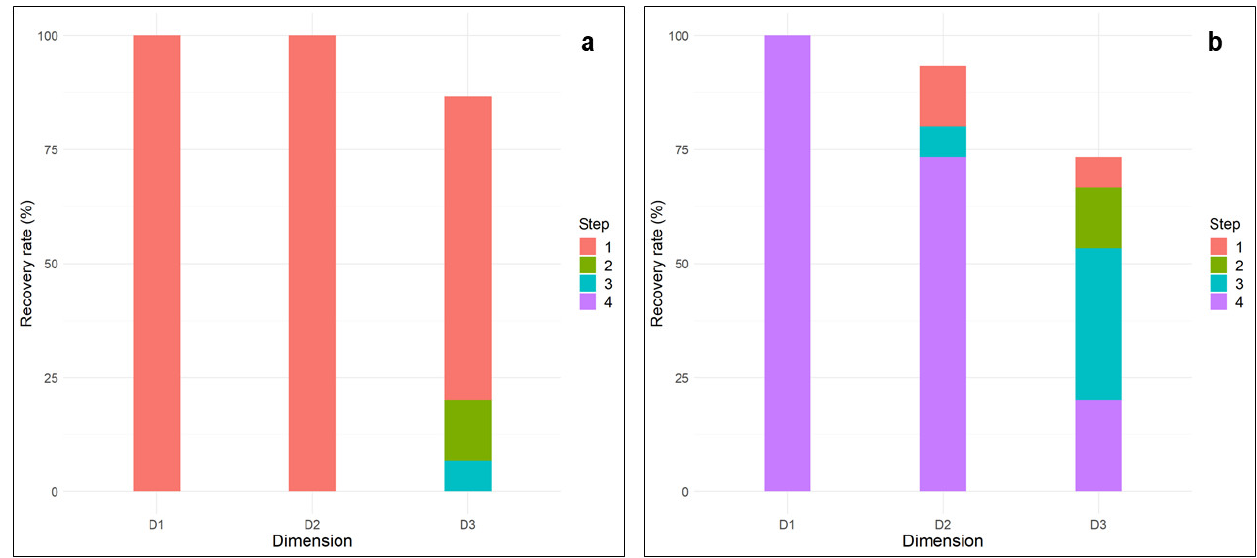
Figure 2. Average percentage recovery rate for the sequential steps (1–3: density separation with NaCl, 4: density separation with NaI) of Protocol number 1 for the different dimensional classes (D1, D2, D3) for ( a ) Nylon particles and ( b ) PET particles.